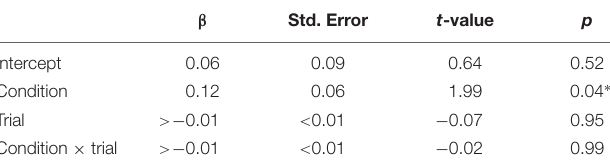
TABLE 3 | Fixedeffects of condition, trial, and condition × trial on pupil dilation. β Std.